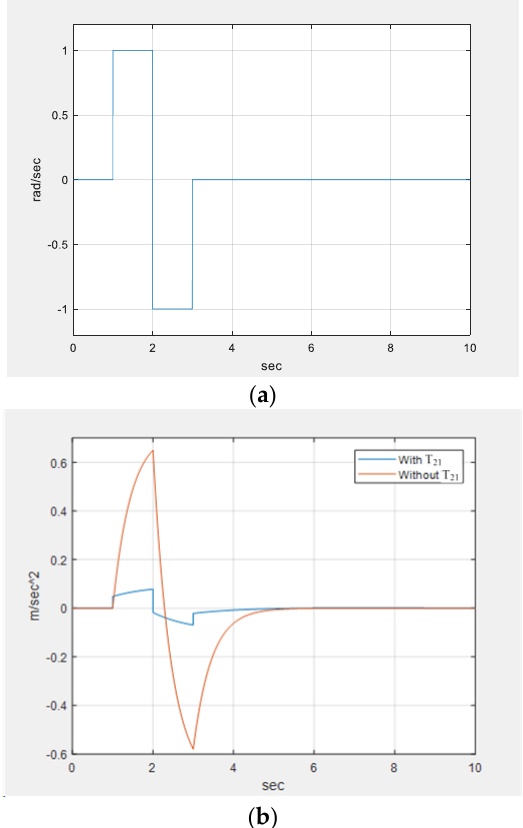
Figure 28. Comparison of motion-cueing algorithms: ( a ) input rotational angular velocity; ( b ) influence of T 21 angular motion on specific